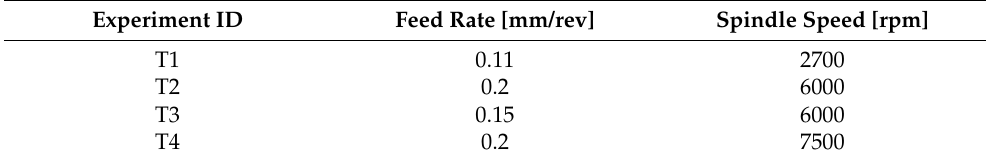
Table 1. Summary of experimental